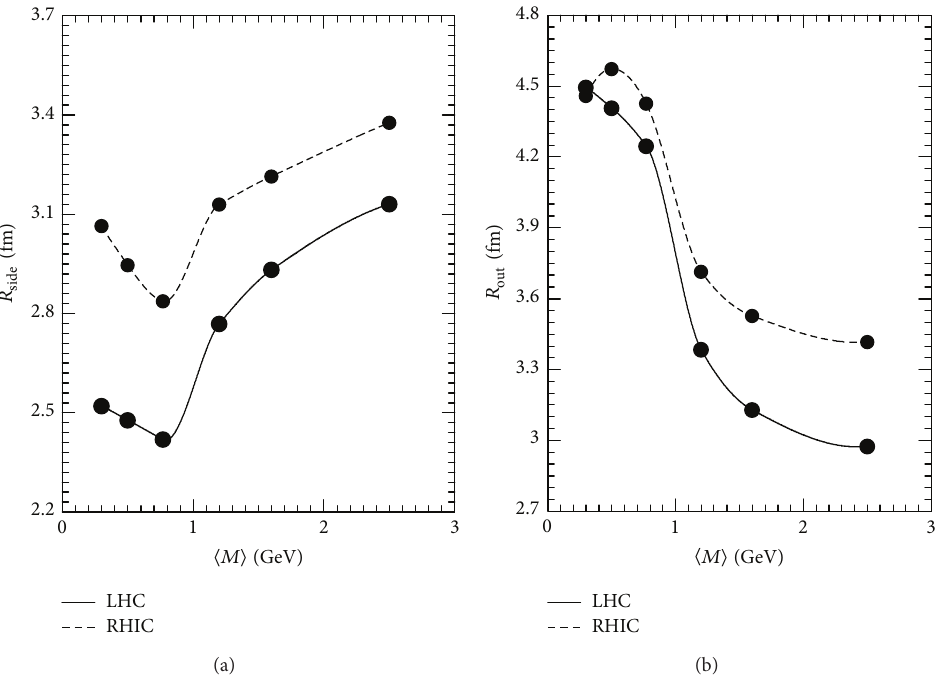
Figure 32: 𝑅 (a) is evaluated with 𝑝 1𝑇 = 𝑝 2𝑇 = 1 GeV and 𝜓 2 = 0 and 𝑅 side of ⟨𝑀⟩ for RHIC (dashed line) and LHC (solid line) energies [14,